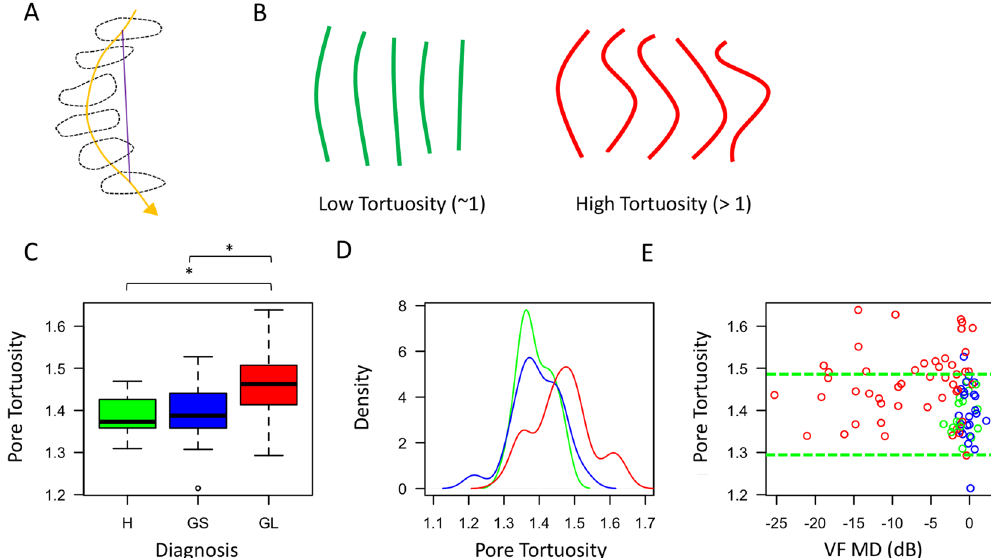
Figure 4. Assessment of pore tortuosity. ( A ) Pore tortuosity was defined by dividing the distance traveled by the pore centroid (yellow line) by the shortest distance between the top and bottom pore (purple line). ( B ) Schematic showing examples of low tortuosity (green) and high tortuosity (red). ( C ) Boxplot of tortuosity as a function of diagnosis (H – healthy, GS – glaucoma suspect, GL – glaucomatous eyes). ( D ) Probability density distribution of pore tortuosity as a function of disease (Green – healthy, Blue – glaucoma suspect, Red – glaucomatous eyes). ( E ) Pore tortuosity as a function of visual field mean deviation, with the green lines denoting the 95% confidence interval of the healthy